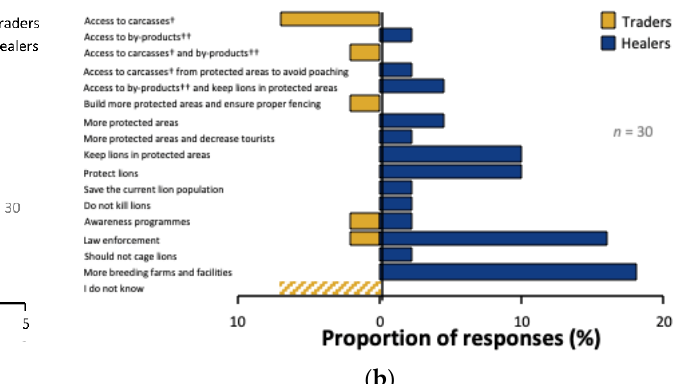
Figure 7. Perceptions of lion population status and sustainability in the trade in lion derivatives. ( a ) Perception of lion population trends and perceived effect of declining lion populations on business or practice, and ( b ) respondent-suggested solutions for ensuring lion parts are accessible in future. † Carcass refers to the material derived from a lion once destroyed, while †† by-products refer